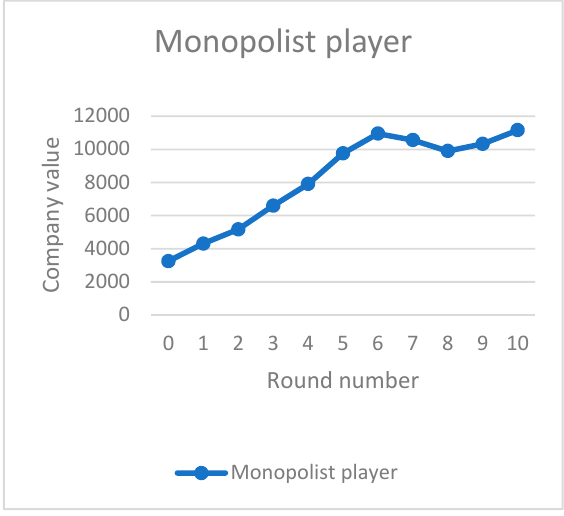
Figure 11. Average company value of Monopolist player.